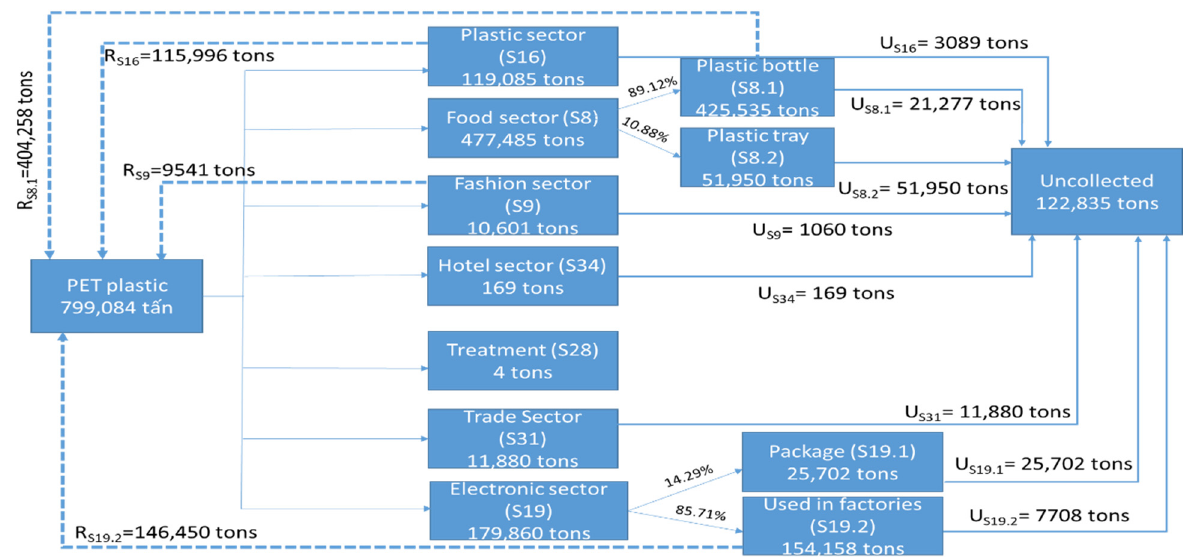
Figure 5: PET pakaging fl ows in